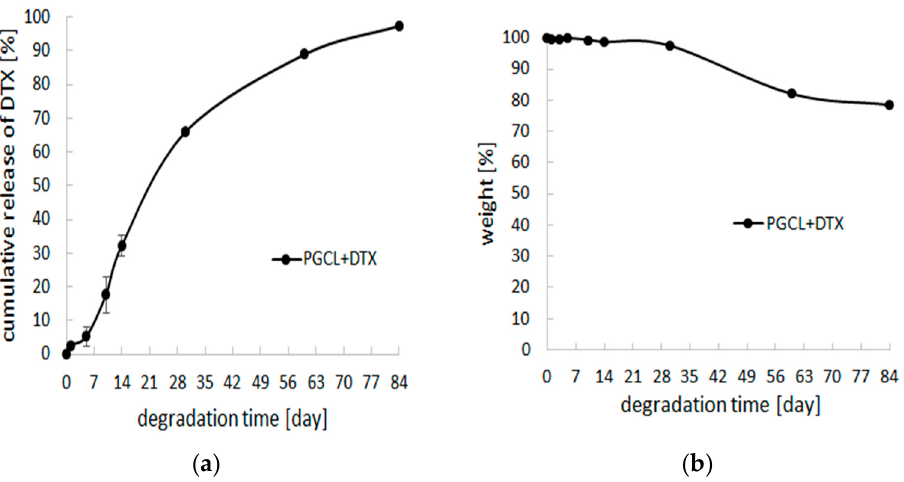
Figure 4. ( a ) cumulative release of DTX-loaded patches, (PLGCL) + DTX, during 84 days of incubation in PBS, pH = 7.4, (n = 3); ( b ) weight changes during degradation of (PLGCL) + DTX patches in PBS, pH = 7.4, (n = 3).